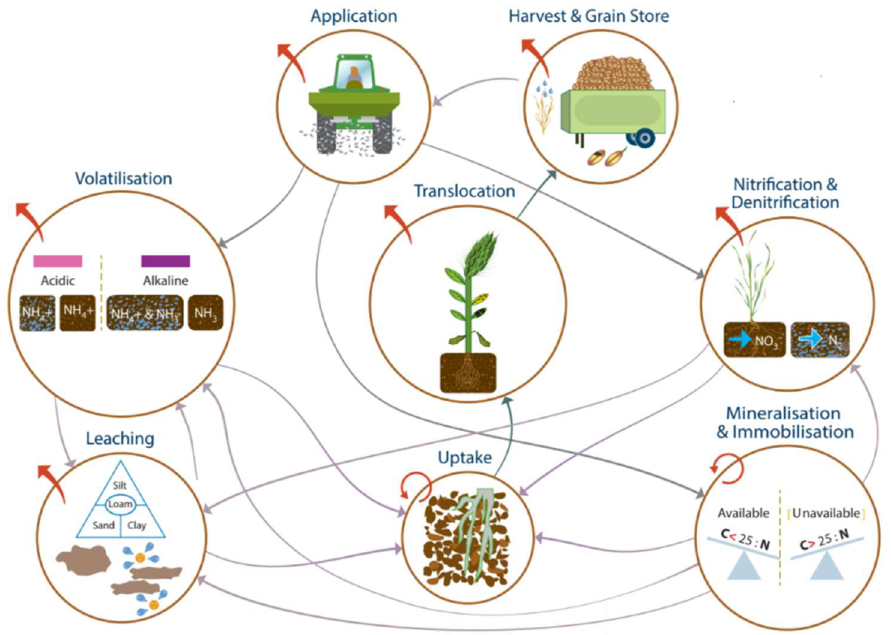
Figure 1. The N loss mechanism web showing interactions between N pools and the processes that regulate inputs, flows, and outputs.